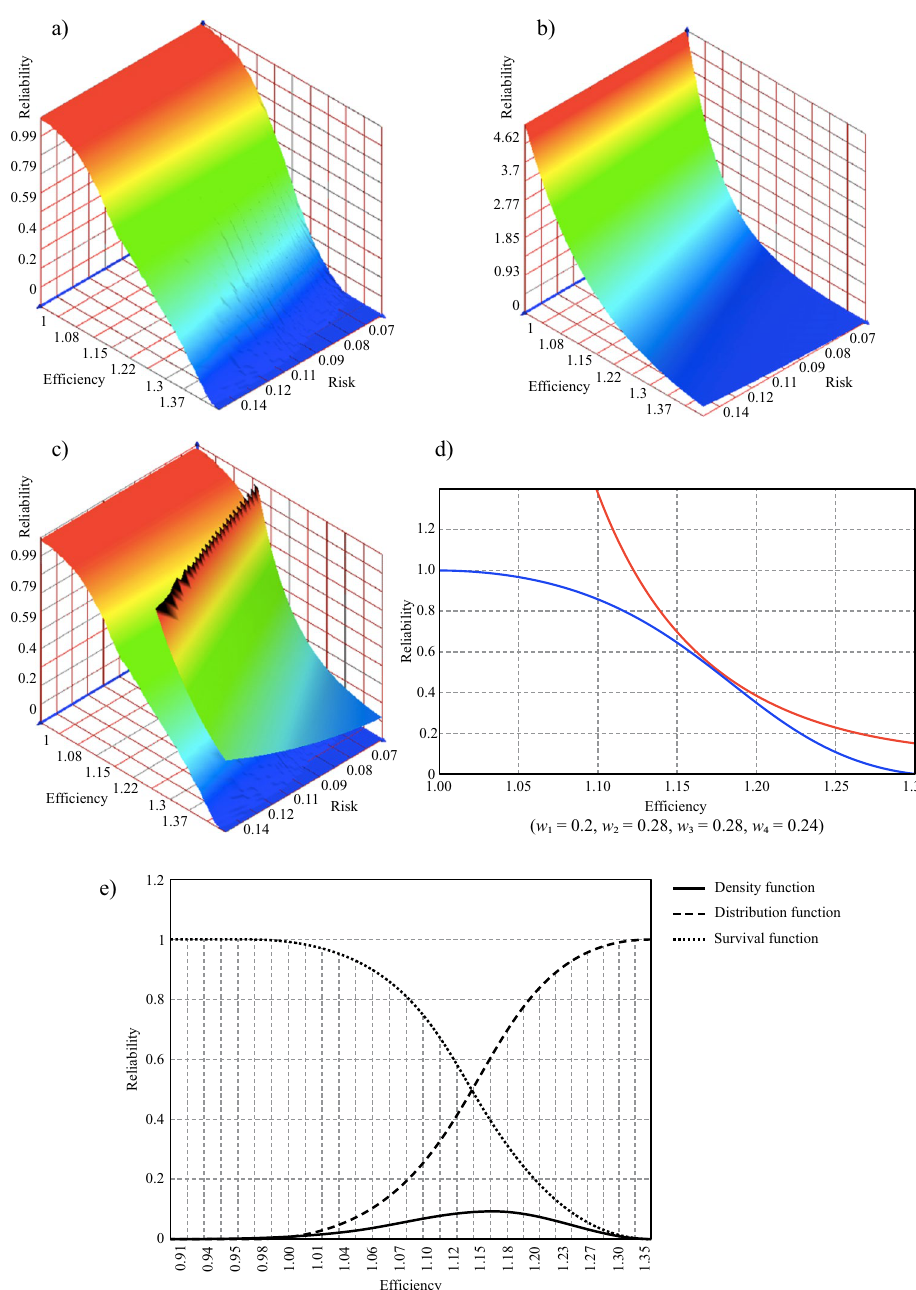
Fig. 7. Scheme of the optimal investment resource allocation where the values of most likely possibilities coincide with the highest values of intervals: efficiency possibilities (a), utility function (b), surface contact point (c), optimal solution (d), and the distribution of the probability of possibilities